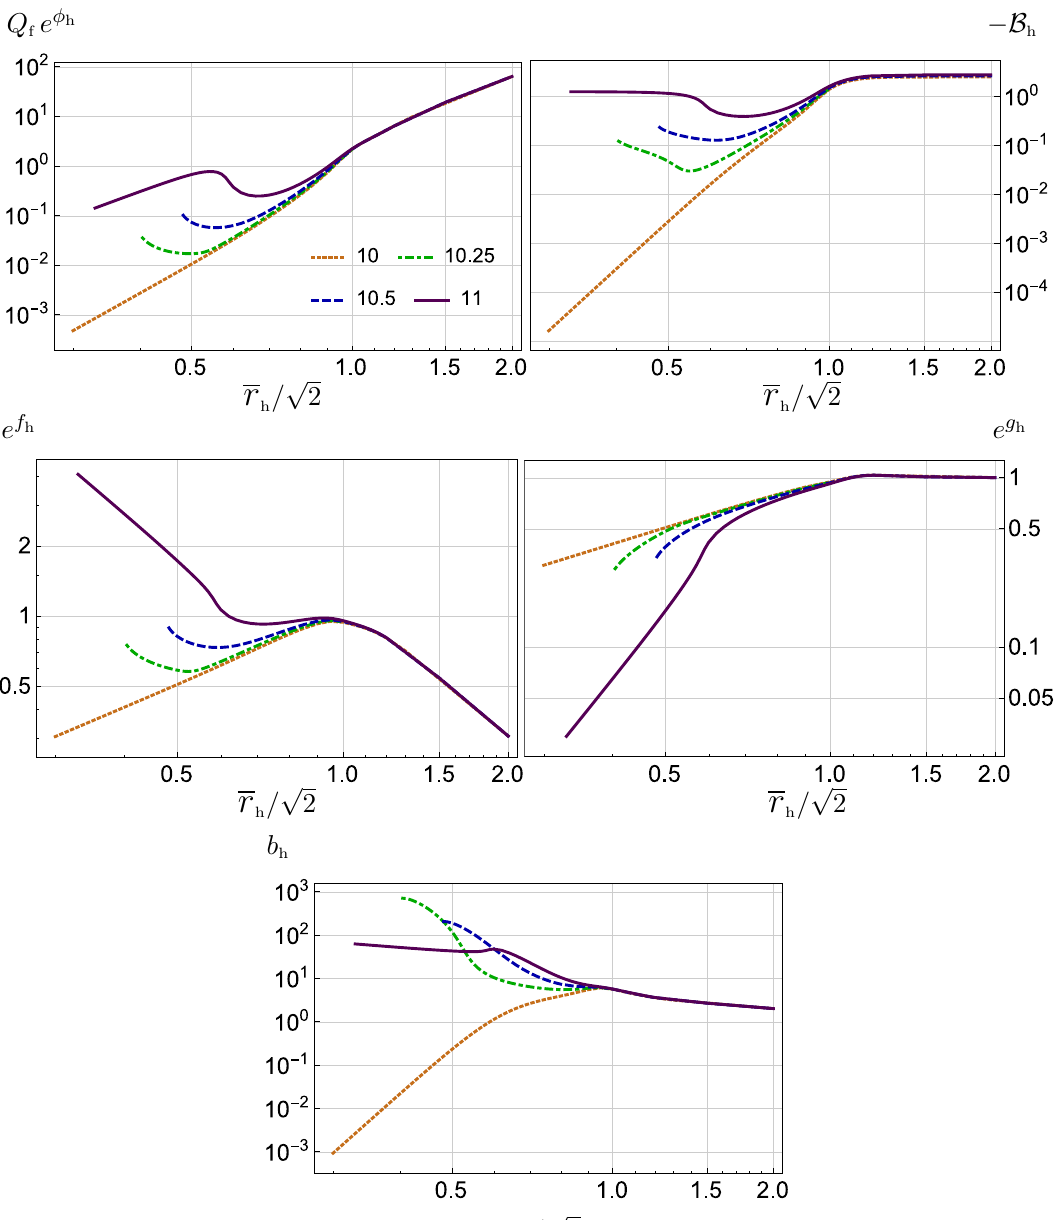
p p 2 N > 2 N (cid:3) q q